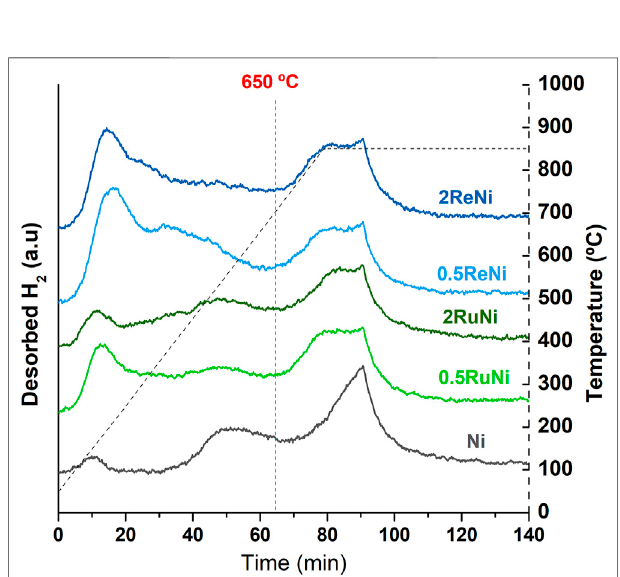
FIGURE 4 | H 2 -TPD pro fi les of the synthesized